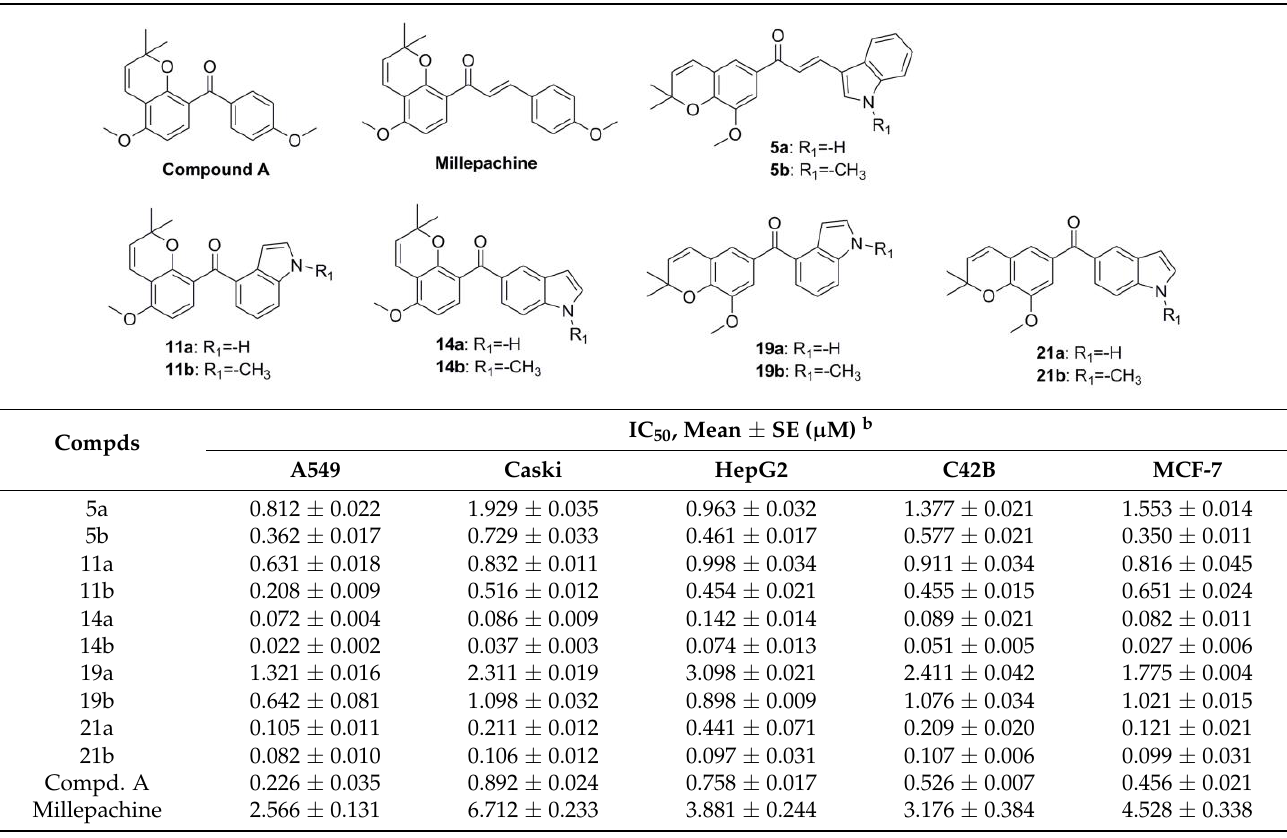
Table 2. Cytotoxicity selectivity of compound 14b toward human non-tumorigenic cell lines and cancer cell lines a